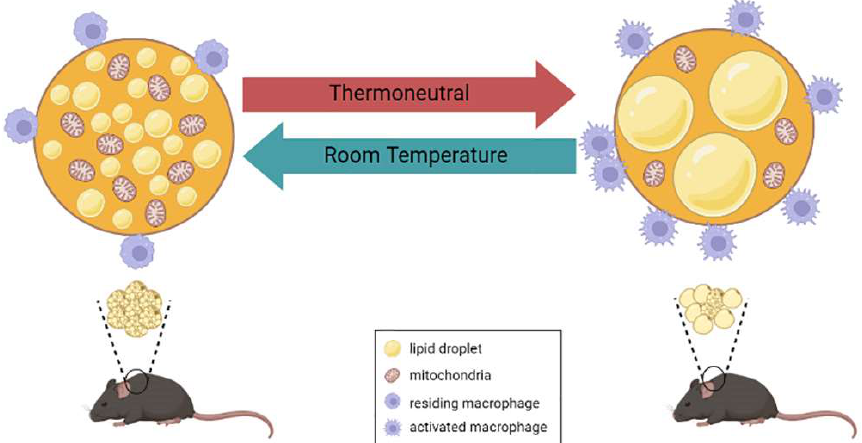
Figure 2. Phenotypes alteration of brown adipocytes in different housing temperatures. In standard animal housing (room temperature or ~21–24 ◦ C), brown adipocytes contain multilocular lipid droplets with a high number of mitochondria. A small number of immune cells, such as macrophages, are known to reside in BAT. Housing the mice in the thermoneutrality (~28–31 ◦ C) alters brown adipocytes phenotypes, observed by the appearance of unilocular lipid droplets and a low number of mitochondria. Higher infiltration of macrophages was also observed in BAT from mice living in the TN zone. These infiltrated macrophages reside in their activated state, reflected by the crown-like structure. Mechanisms such as autophagy-mediated mitochondria clearance and ChREBP-dependent lipid accumulation contribute to thermoneutrality-induced BAT